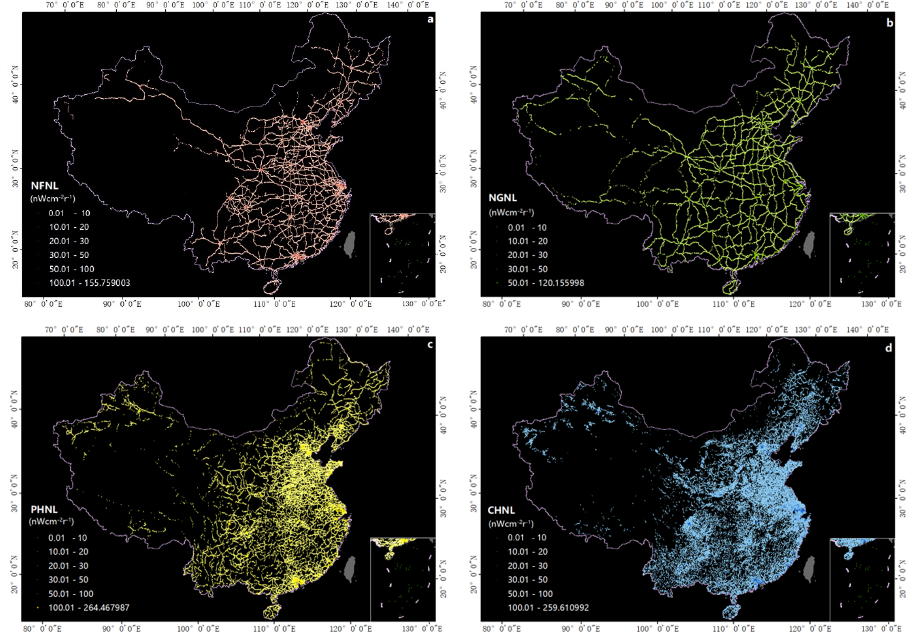
Figure 7. Highway nighttime lightmaps: ( a ) is the 2015 freeway nighttime light maps of China, ( b ) is the 2015 national general highway nighttime light map of China, ( c ) is the 2015 freeway nighttime light maps of China, ( d ) is the 2015 freeway nighttime light maps of China.